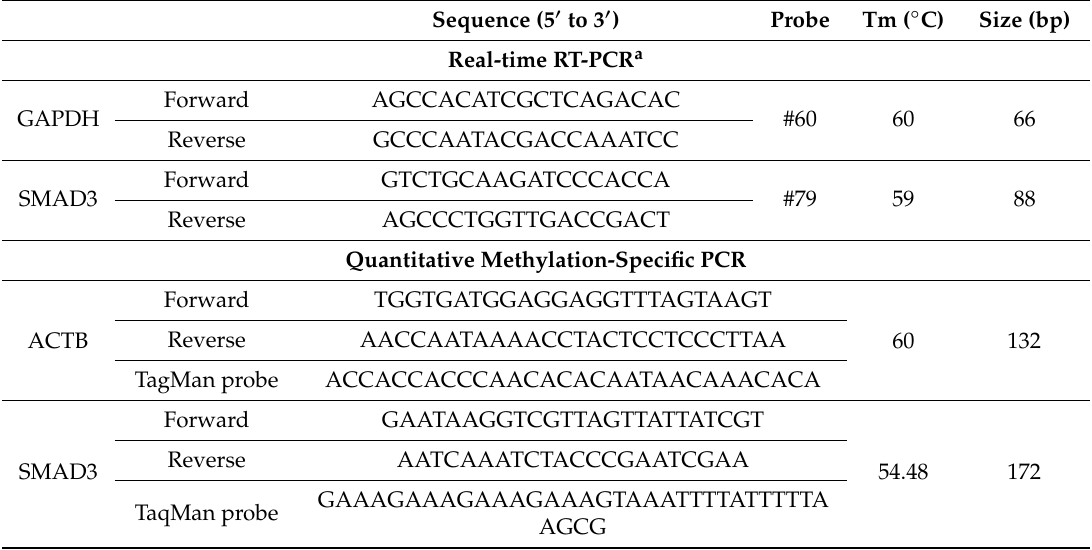
Table 3. List of primer sequences and their reaction conditions used in the present